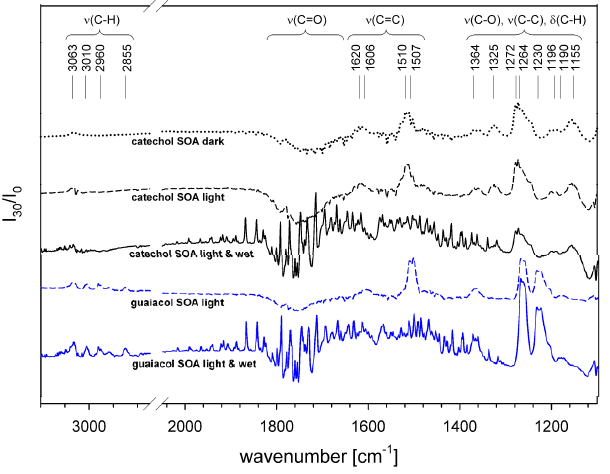
Fig. 8. ATR spectra of secondary organic aerosol particles from catechol and guaiacol sampled by electrostatic precipitation onto the KRS-5 crystal. Assignments of the observed bands are listed in Table 1.